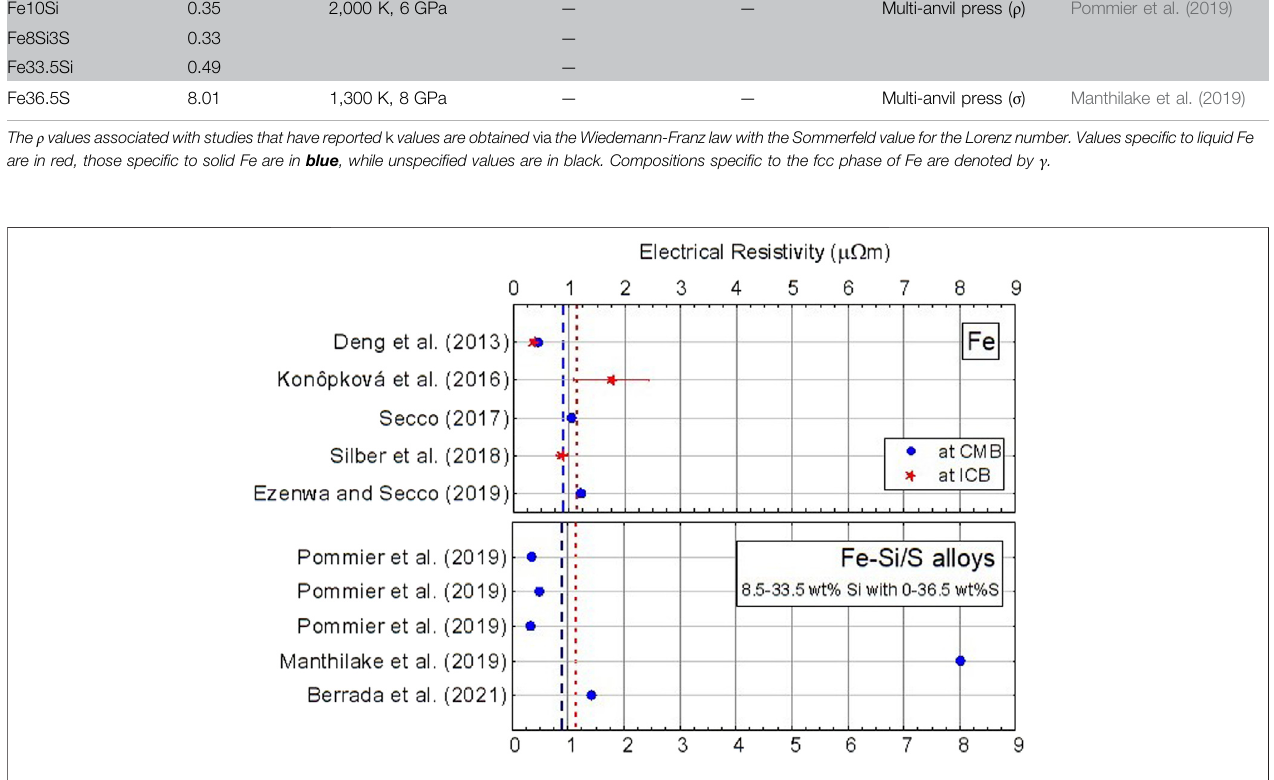
FIGURE 4 | Combined values of ρ from the literature applied to Mercury ’ s core presented in date order. The blue dashed line represents the average values at the CMB,whilethereddashedlinerepresentstheaveragevaluesattheICB.TheaverageofallreportedvaluesatCMB(1,900 K,5 GPa)conditionsis0.88 µ Ω